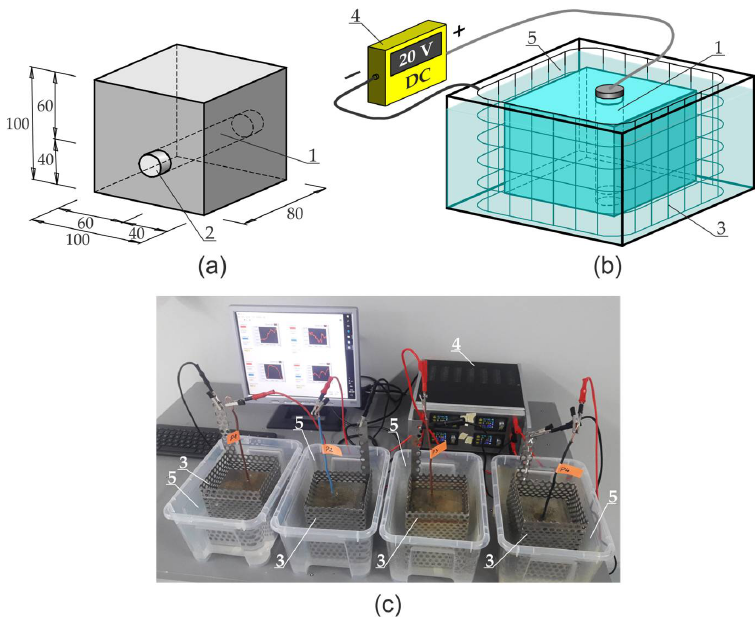
Figure 4. Stand for testing accelerated corrosion of the reinforcement using the potentiostatic method: ( a ) schematic of the sample with the location of reinforcing bar, ( b ) measuring system, ( c ) view of the stand with power supply unit and four samples – description in the text. Table 1. Chemical composition of steel St3SX (S235JRG1) (%)